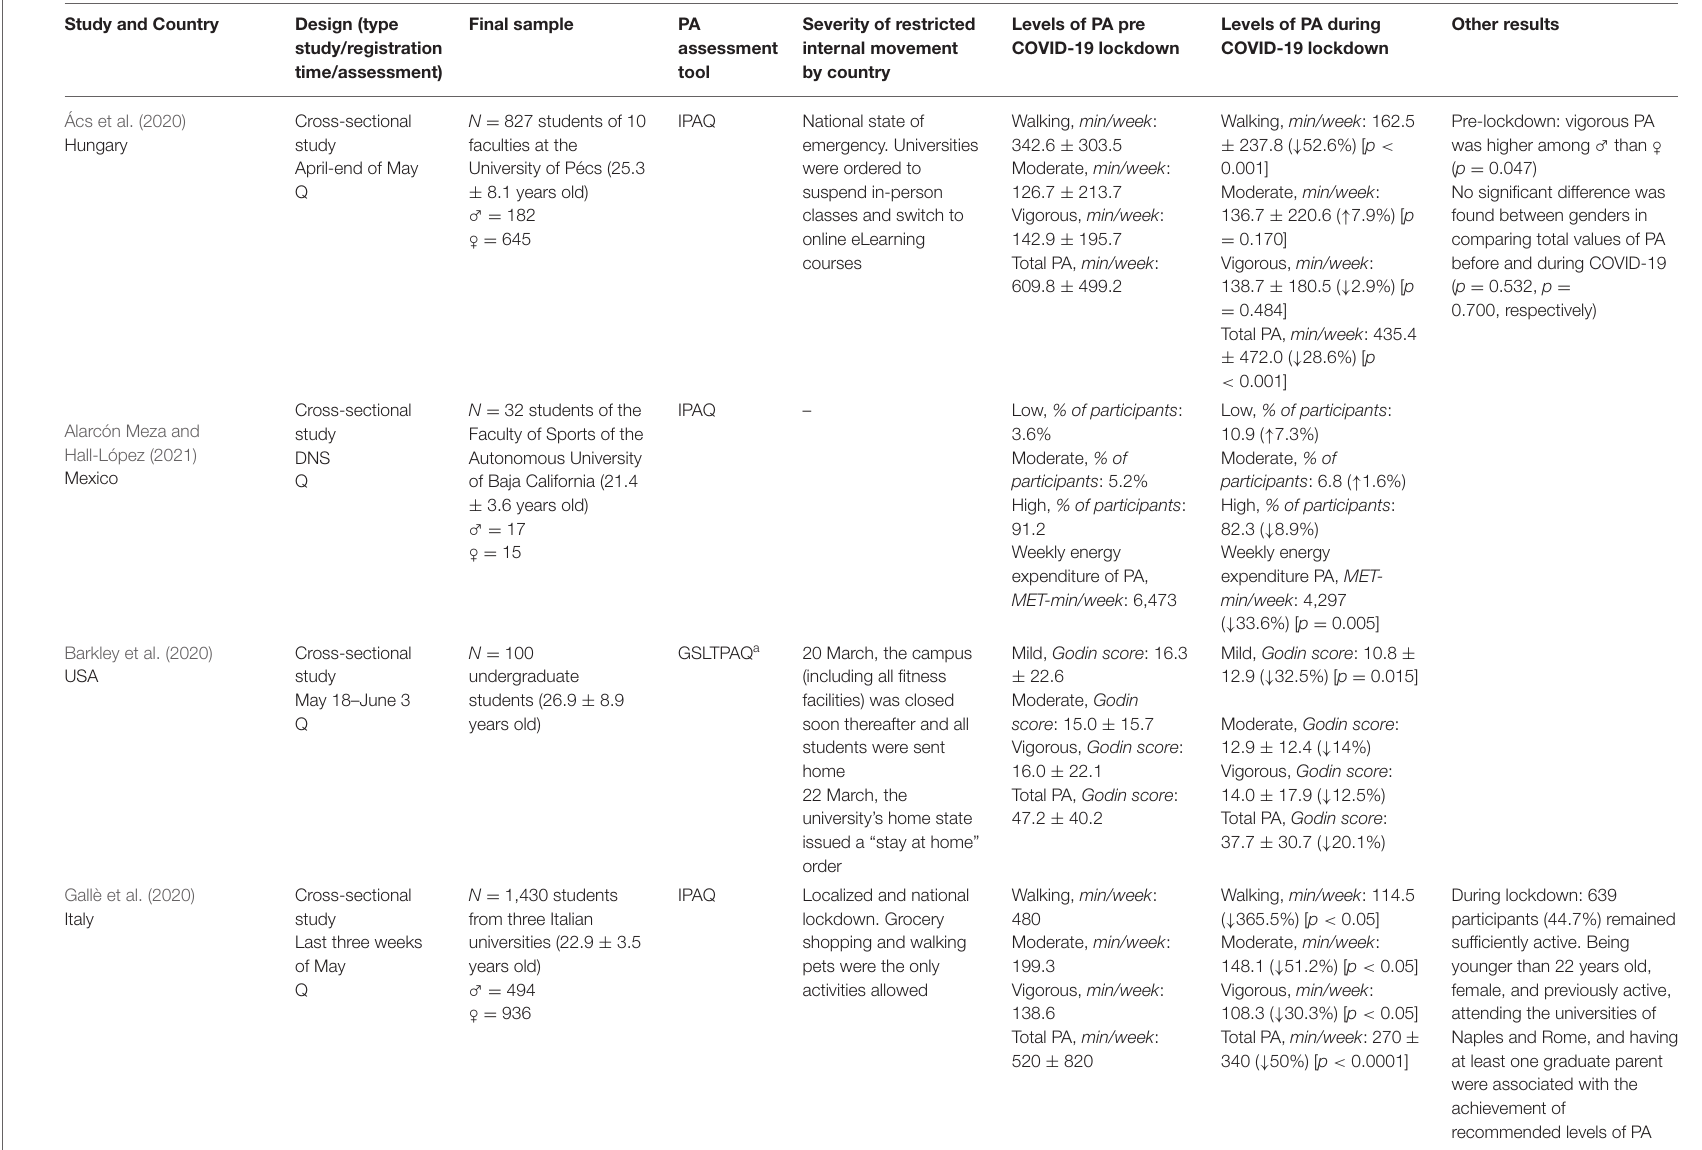
TABLE 1 | Characteristics of the included studies in the